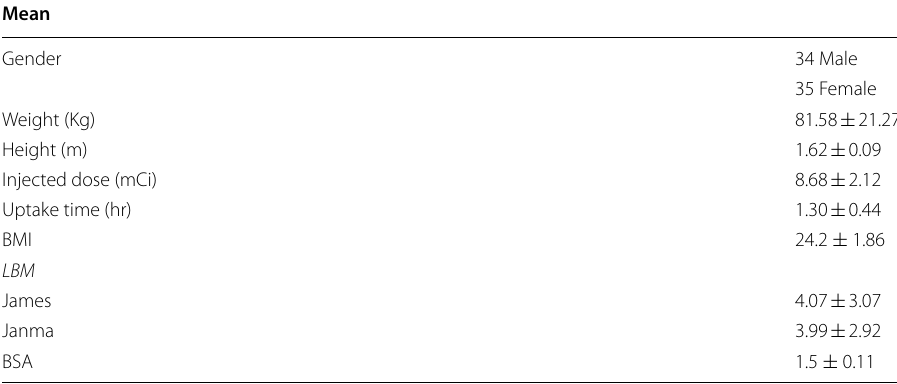
N 69 patients (35 females, 50.7% and 34 males, =